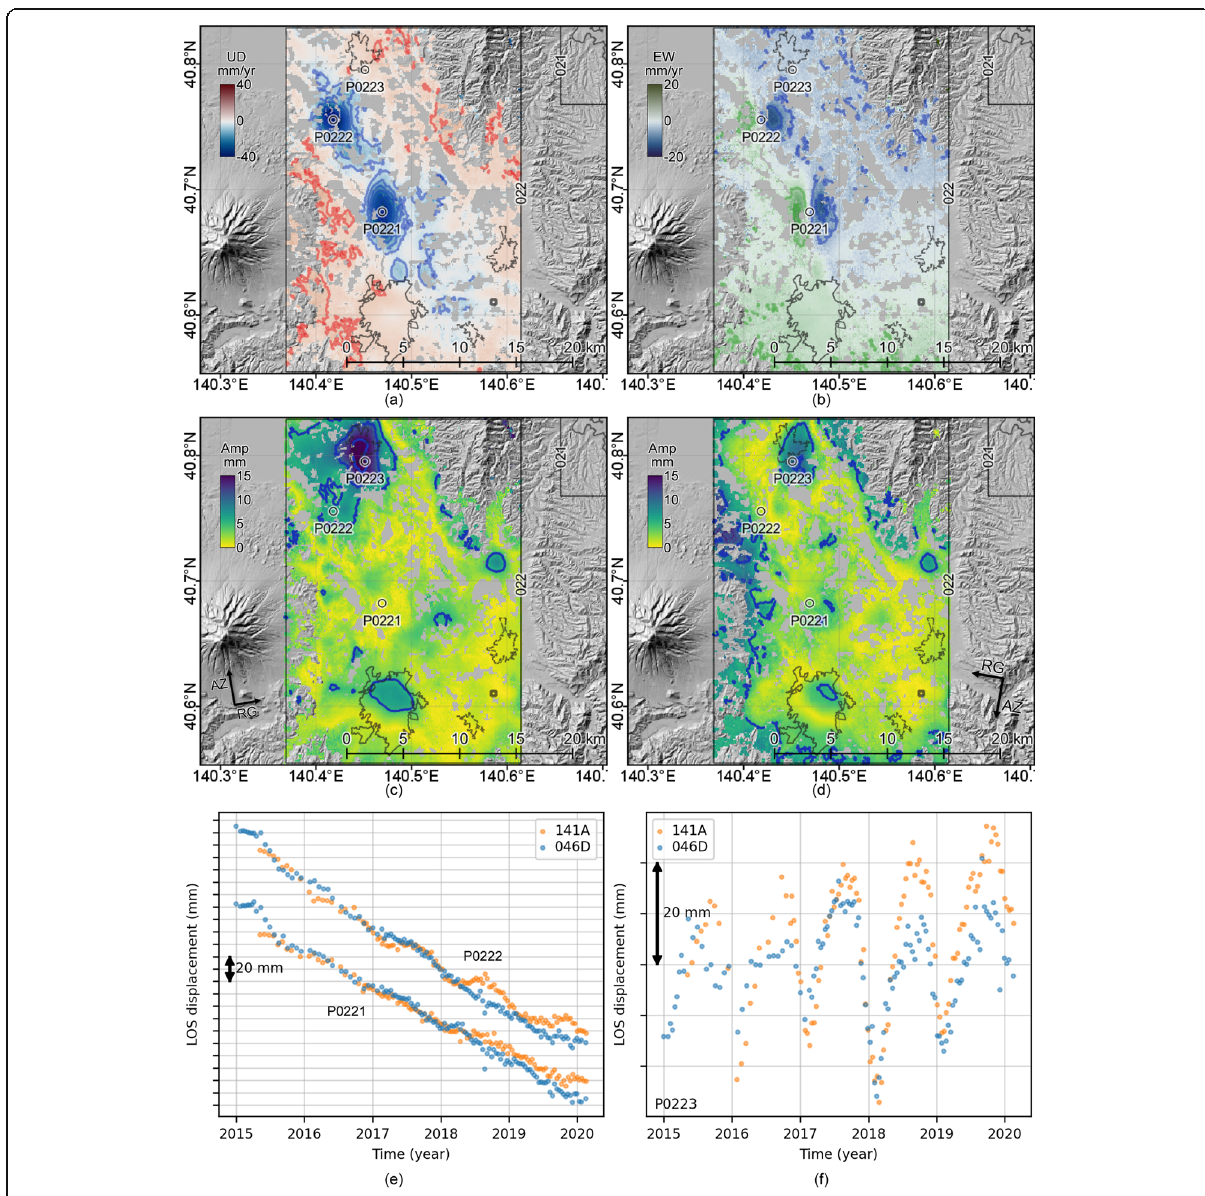
Fig. 10 a Unmasked vertical deformation velocities in Hirosaki (ID: 022). The black lines denote the outlines of the DID. The interval of the red (uplift) and blue (subsidence) contour lines is 5 mm/year without the 0 mm/year lines. The black square denotes the reference point. b Unmasked EW deformation velocities. The interval of the green (eastward) and blue (westward) contour lines is 5 mm/year without the 0 mm/ year lines. c Amplitudes of the annual LOS fluctuation from the ascending 141A_04925_131313. The interval of the contour lines is 5 mm. d Amplitudes from the descending 046D_04907_081313. e LOS deformation time series at P0221 and P0222 for each frame. f LOS deformation time series at P0223 for each